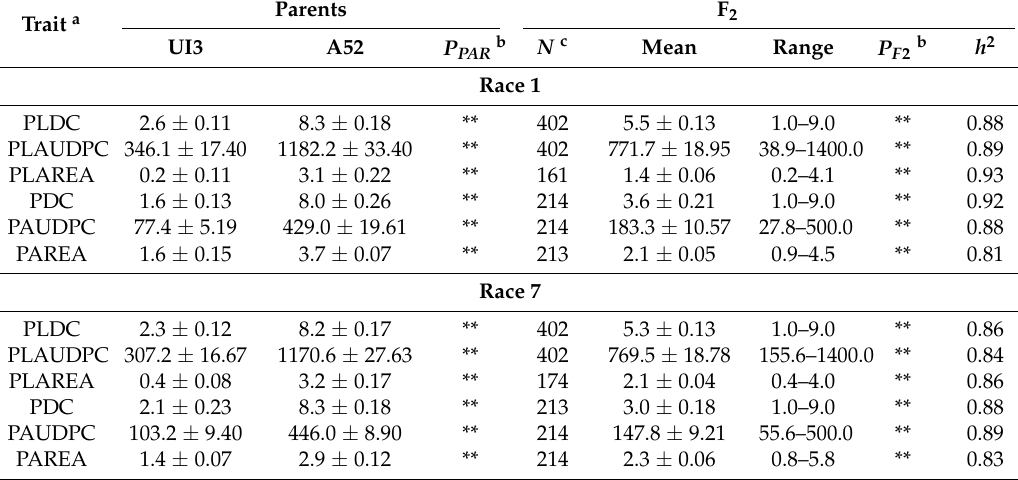
Table 2. Mean, standard error, range of variation, variance analysis results and narrow-sense heritabilities ( h 2 ) for DC, AUDPC and AREA for primary leaf and pod against halo blight races 1, 7 and 9, of the two common bean parents, UI3 and A52, and the F 2 UI3A52